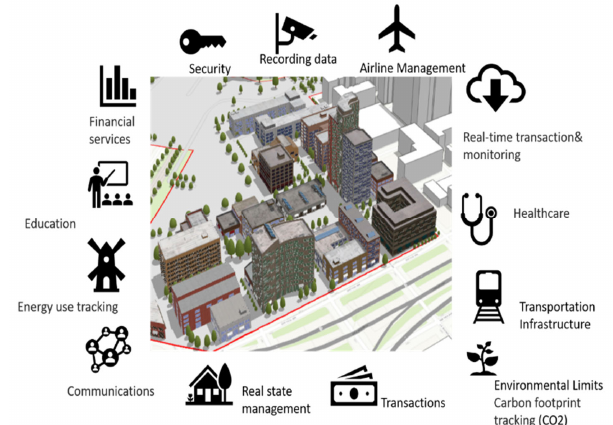
Figure 1. Blockchain in the infrastructure of smart cities.